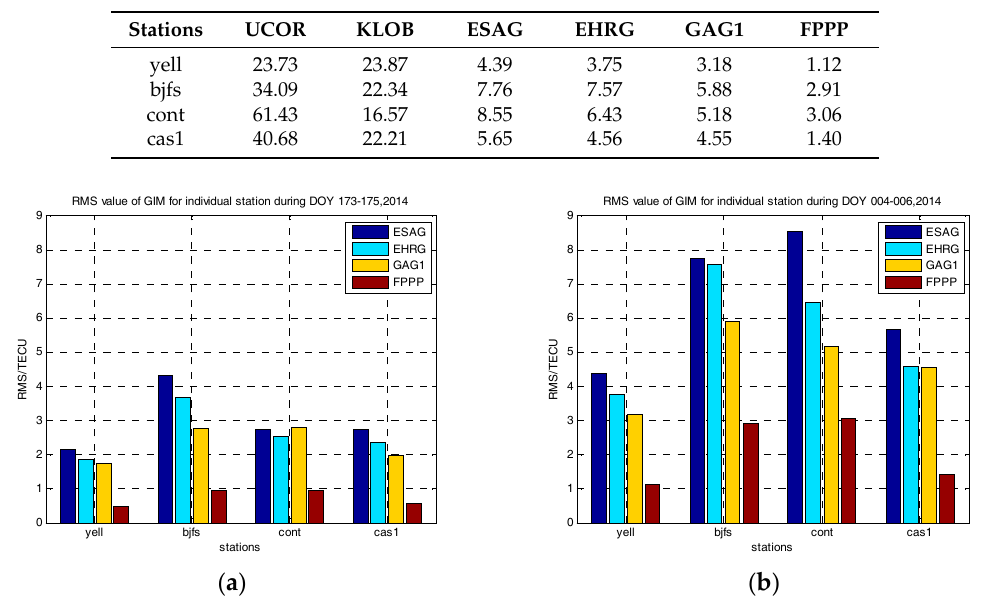
Figure 2. The RMS of individual station for Case 1 ( a ) and Case 2 ( b ).